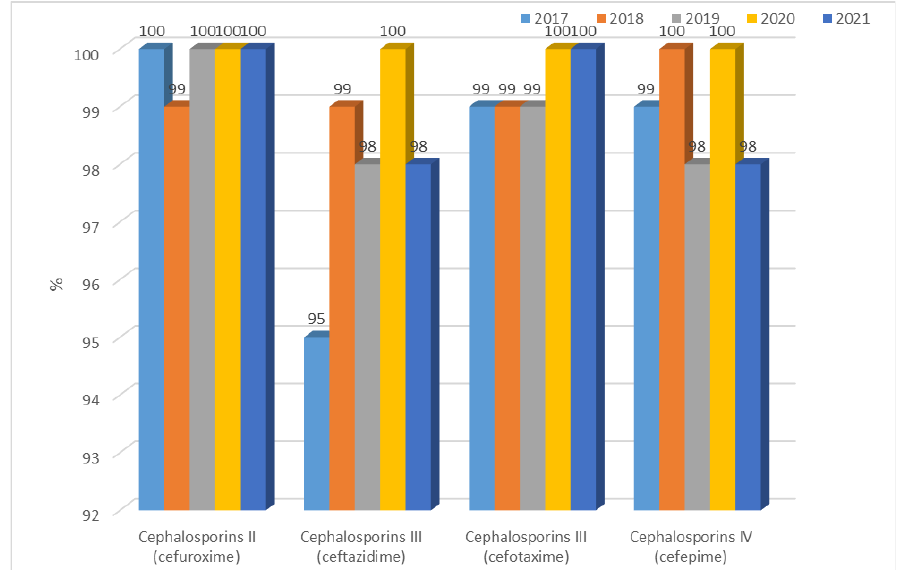
Figure 16. Percentage of K. pneumoniae ESBL(+) strains resistant to cephalosporins.